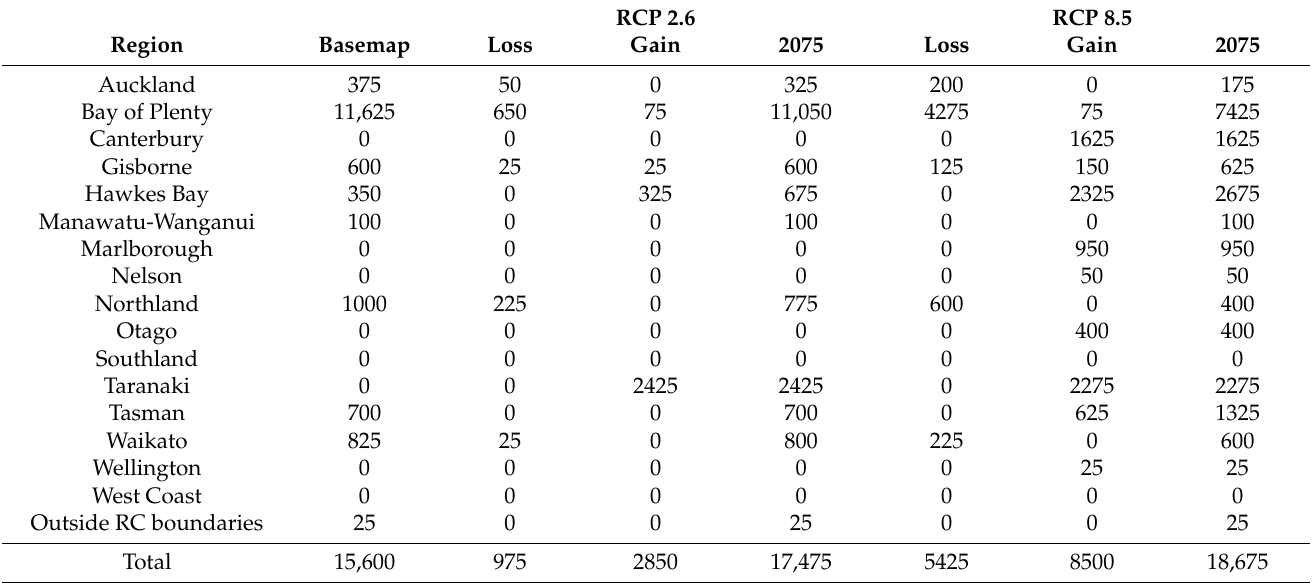
Table 4. Simulated land use (hectares) by region for kiwifruit under mild (Representative Concentra-